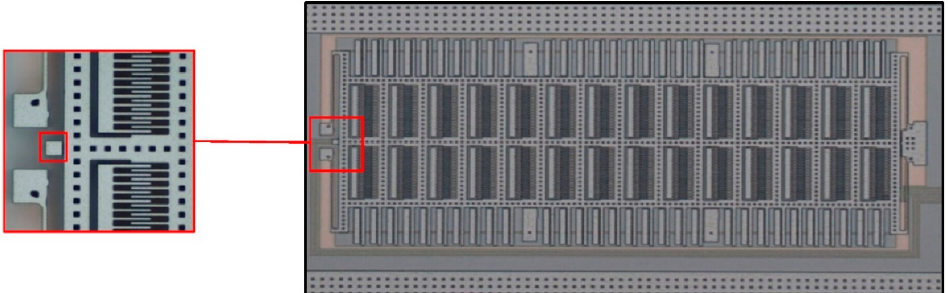
Figure 1. Picture of the device used in the experimental campaign. Inset on the left shows detail of the stopper.